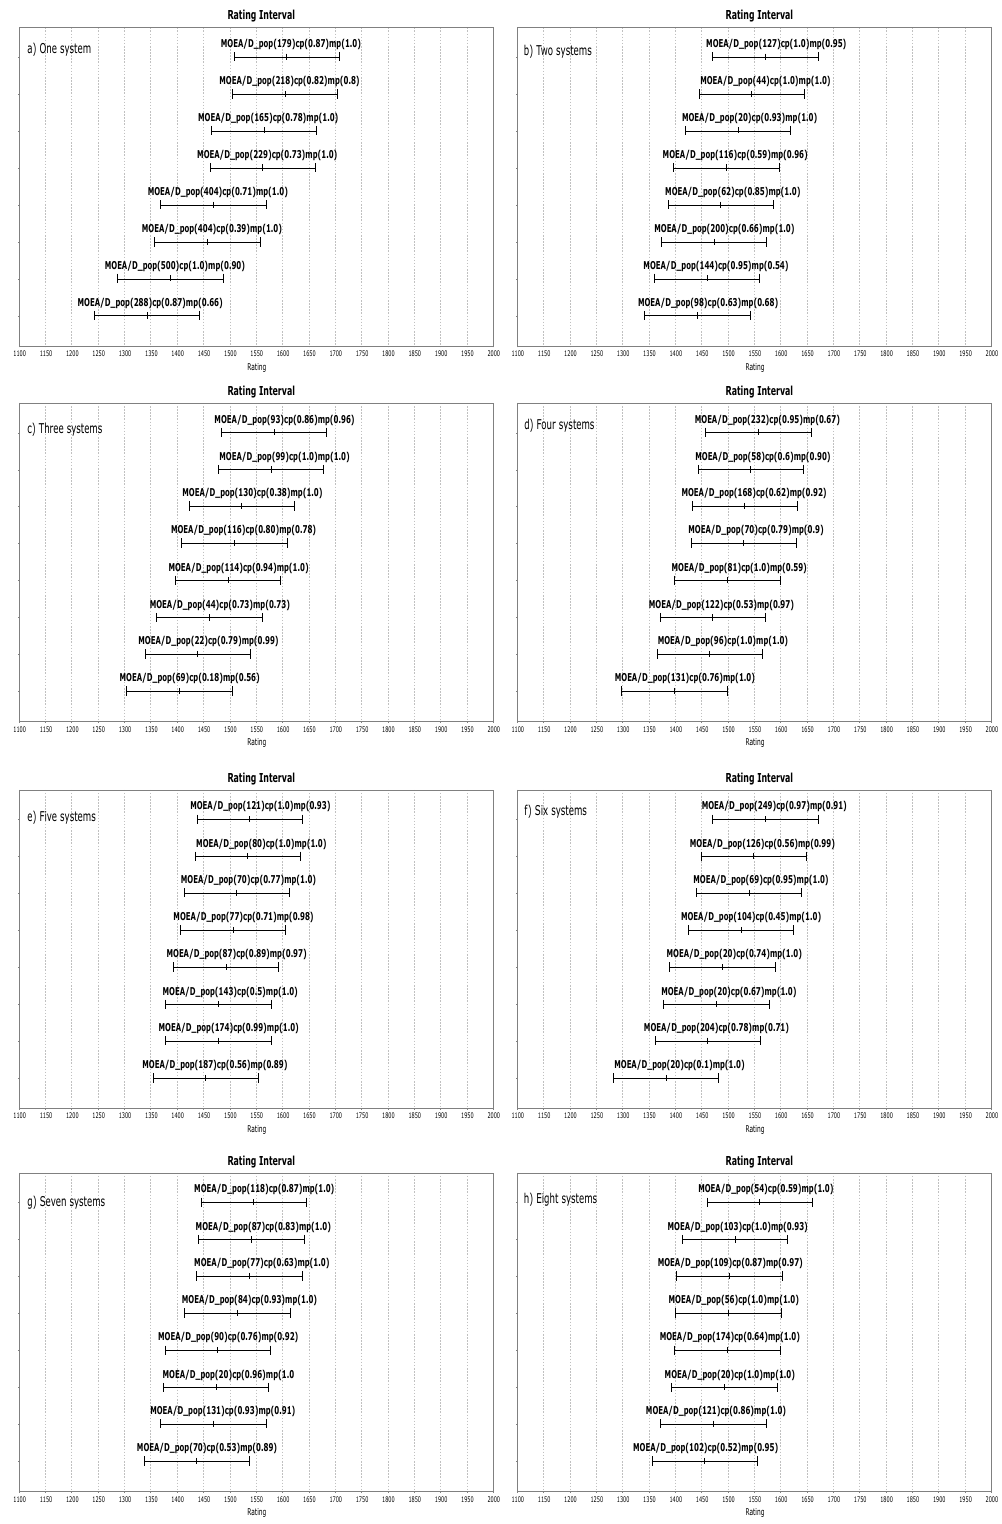
Figure 5. Rating intervals for configurations obtained from the eight repetitions within the MOCRS-Tuning process ranked on eight different problem sets. For each configuration, the control parameters population size (pop), crossover probability (cp) and mutation probability (mp) are